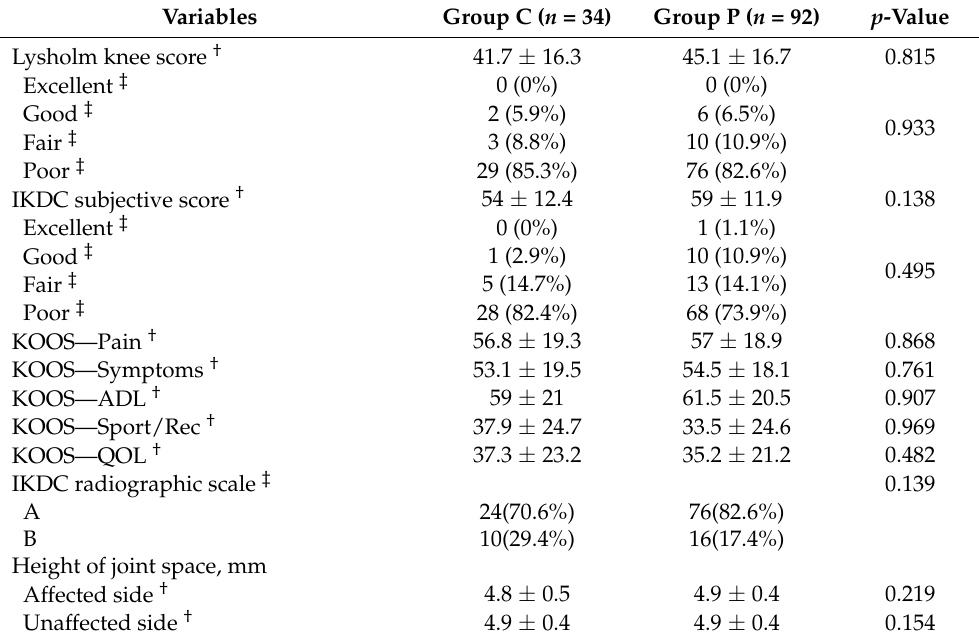
Table 2. Comparison of preoperative variables between the